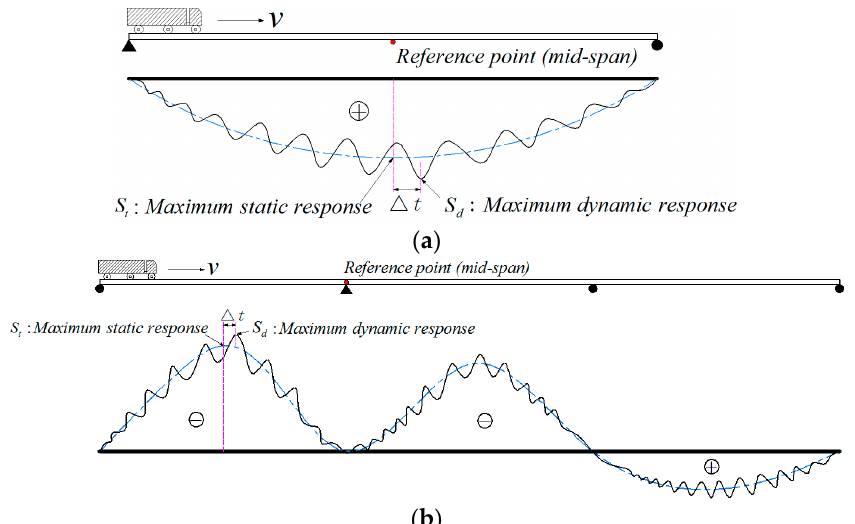
3 of 24 Figure 1. Time-history curves of static and dynamic response due to vehicles. ( a ) Response of a simply supported girder bridge; ( b ) Response of a continuous girder bridge. ∆ t is the hysteresis time between dynamic and static response. ○ + represents the positive effect; ○ - represents the negative effect conversely.